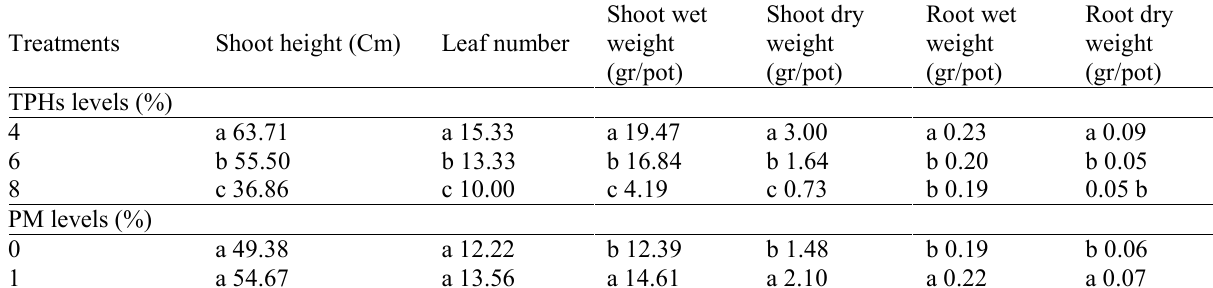
Note: Mean values in each column or row followed by the same capital or lowercase letter and mean values in the body of the table followed by the same lowercase letters are not significantly different (P<0.05) according to Duncan’s multiple range